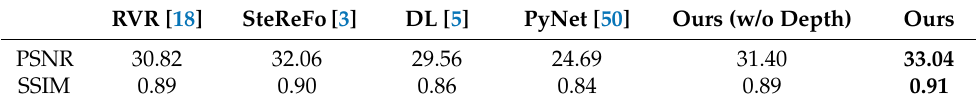
Table 6. Quantitative results of different rendering methods on the NJU2K [72]